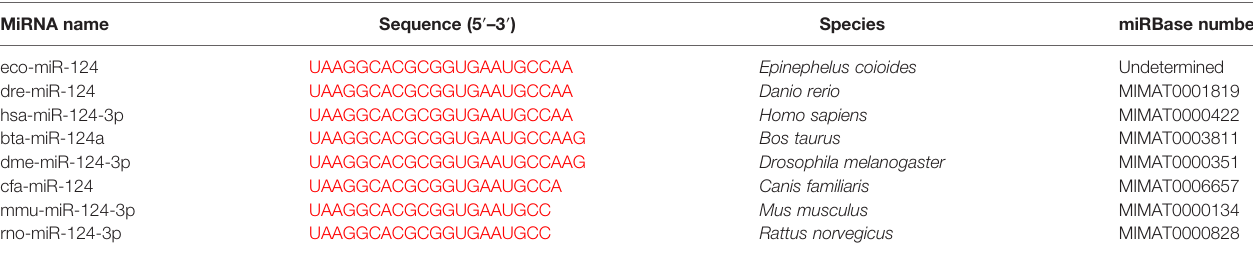
TABLE 2 | Sequence of miR-124 in different species.